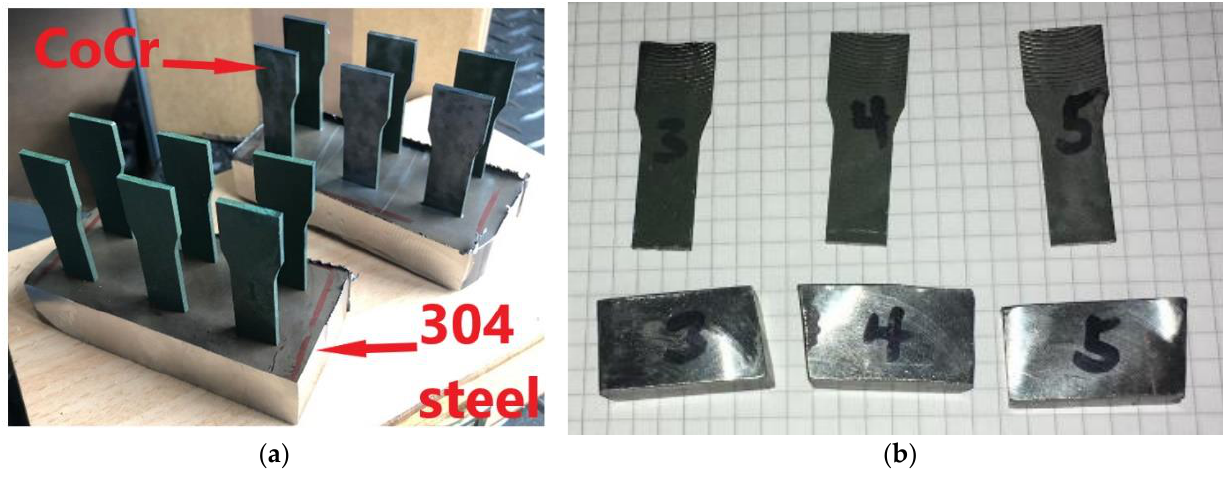
Figure 5. ( a ) SLM-fabricated specimens to test the adhesion between CoCr and the 304 substrate. The specimens after stress relief heat treatment: ( b ) CoCr – 304 specimens after mechanical testing.